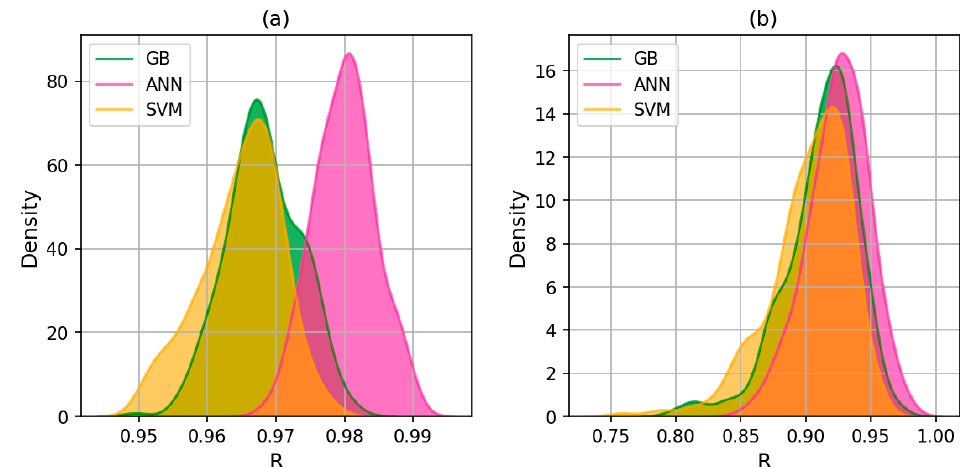
Figure 8. Density curve of the performance indicator R on 300 samplings with the: ( a ) Training set and ( b ) Testing set.